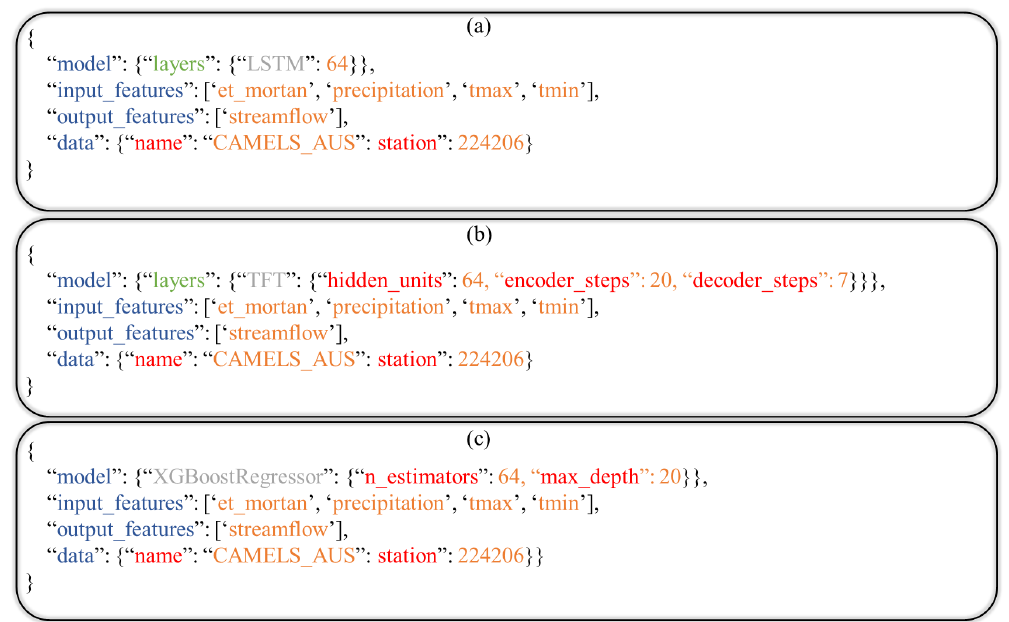
Figure 4. Examples of declarative model definition in a config.json file. Panel (a) shows an example of an LSTM-based model using the CAMELS_AUS data (Fowler et al., 2021). Panels (b) and (c) show contents of configuration file for using temporal fusion transformer (Lim et al., 2021) and XGBoost (Chen and Guestrin, 2016) for rainfall–runoff modeling using CAMELS_AUS data,